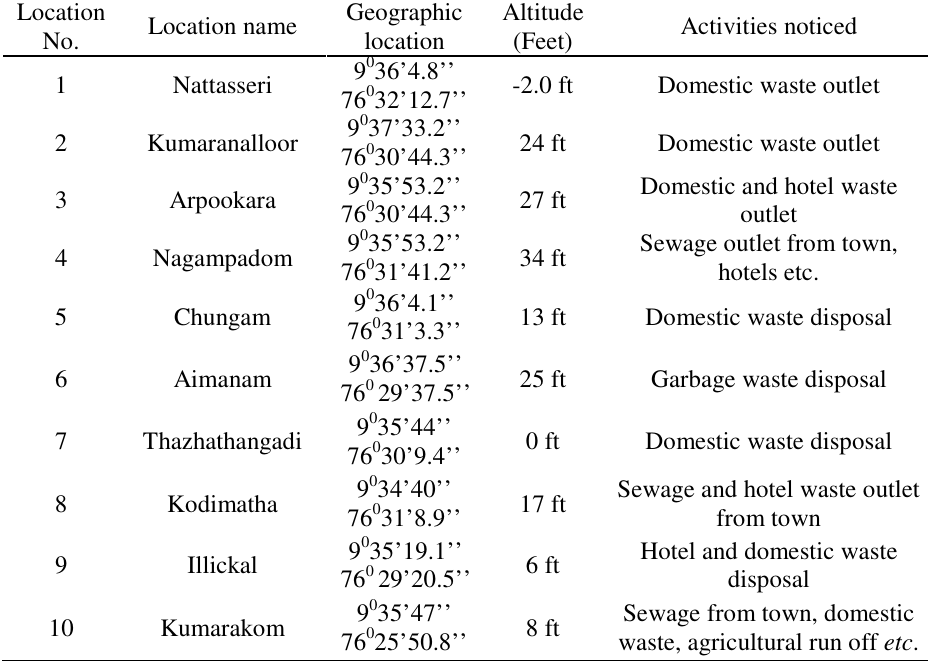
Table 1. Description of sampling